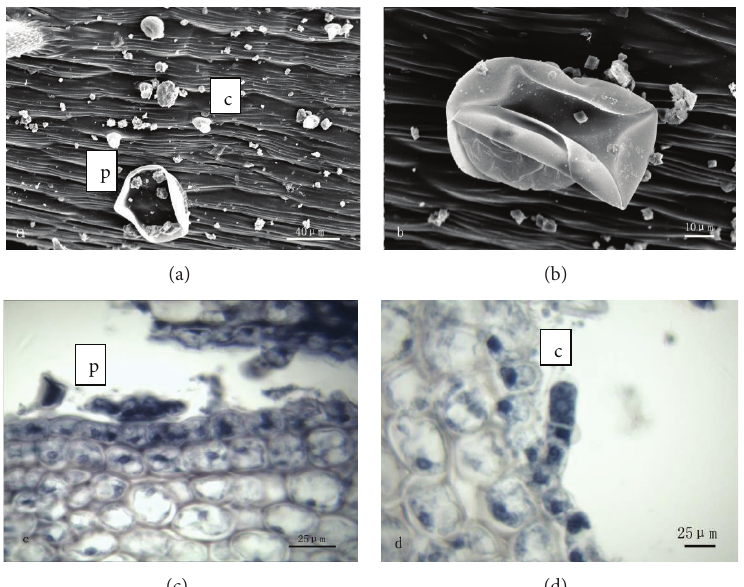
Figure 2: ((a), (b)) SEM micrographs showing the morphology of glandular trichomes on stem of T. quinquecostatus. (a) Peltate trichomes (p) and capitate ones (c). (b) A peltate trichome. ((c), (d)) Transverse sections of T. quinquecostatus stem. (c) A peltate trichome (p). (d) A capitate trichome (c).